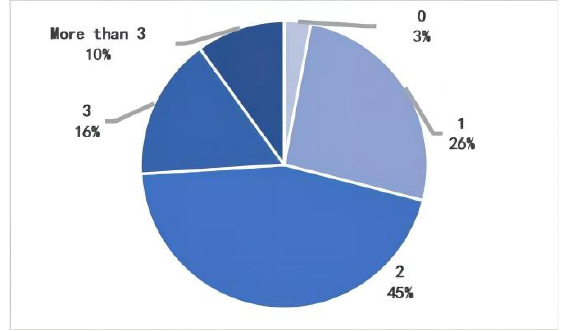
Figure 10. Number of parking lots passed on the walk.